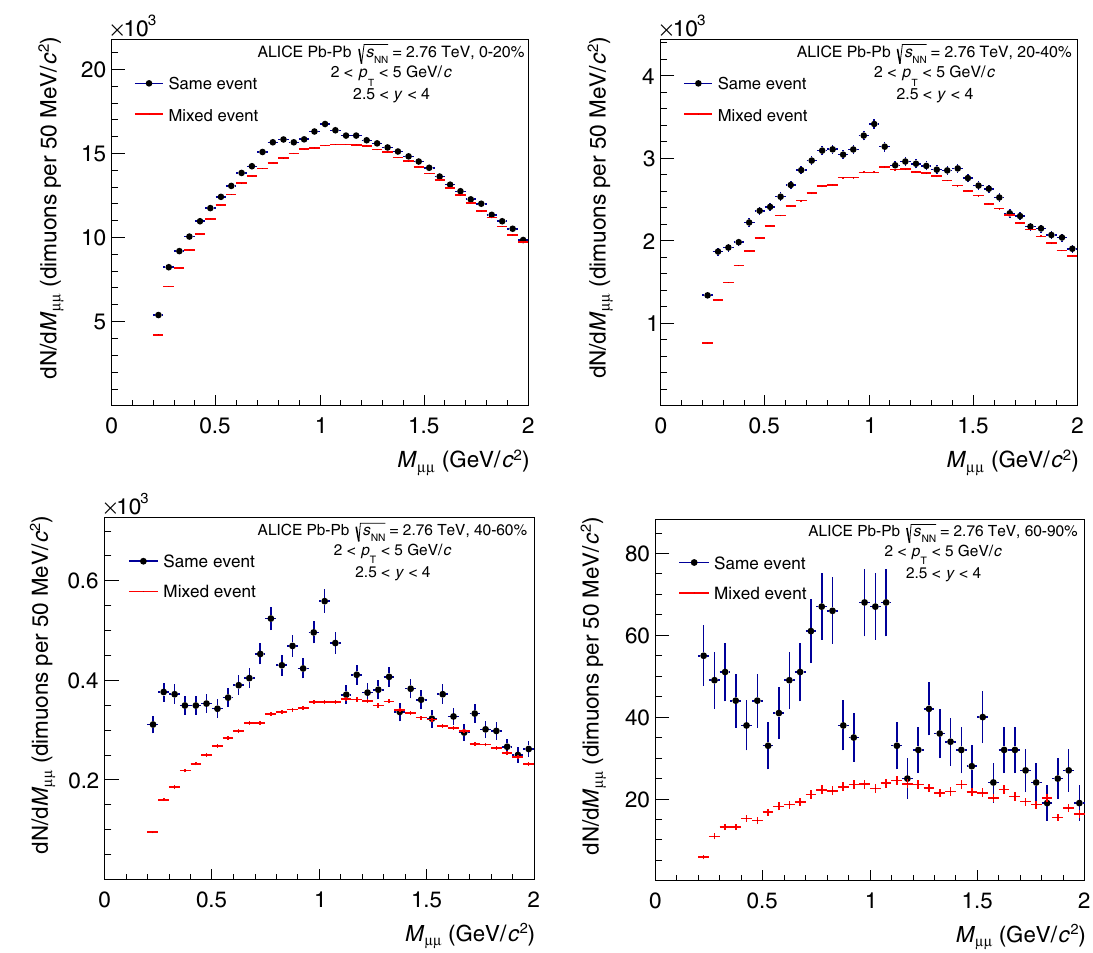
Fig. 1 Invariant mass spectra for opposite-sign muon pairs in different centrality classes, in the range 2 < p T < 5 GeV/c. The combinatorial background, evaluated from opposite-sign pairs in mixed events, is also shown